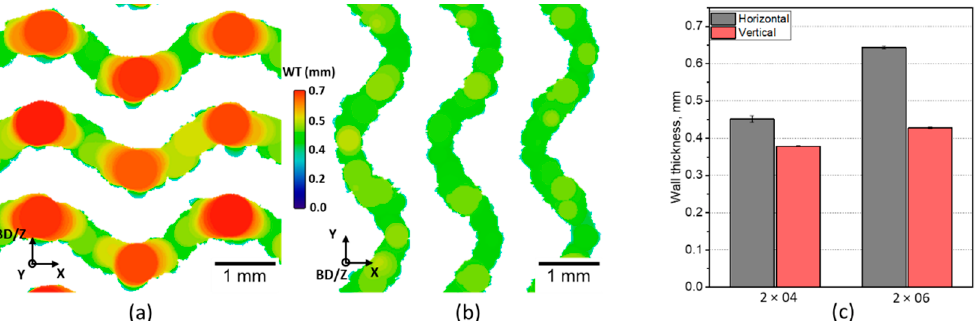
Figure 6. Comparison of the WT in the horizontal (printed normal to BD) and vertical (printed parallel to BD) sections: ( a ) Example of the CT-slice containing the horizontal wall of the 2 × 06 specimen; ( b ) example of the CT-slice containing the vertical wall of the 2 × 06 specimen; ( c ) quantitative comparison of WT in 2 × 04 and 2 × 06 specimens. BD indicates the build direction.